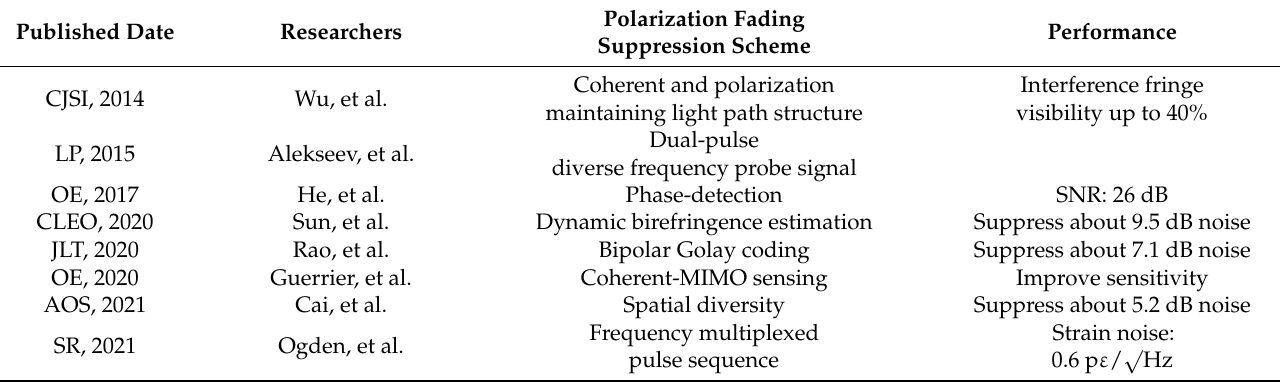
Table 1. Research progress for suppression of polarization fading.